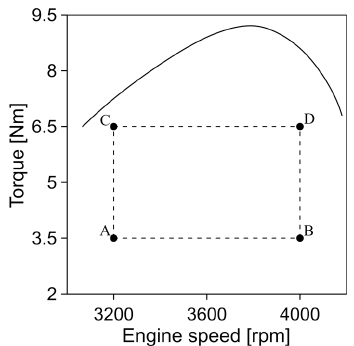
Figure 4. Engine operating conditions.